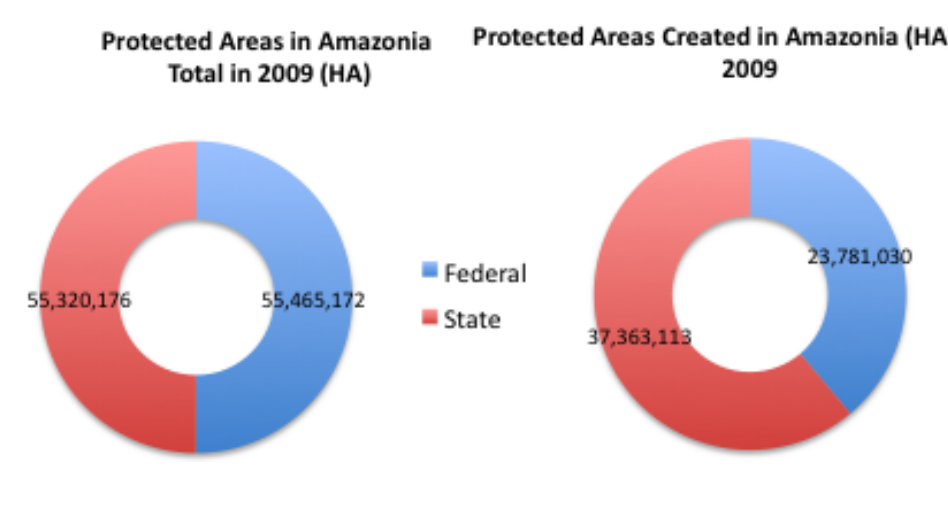
Figure 1. Protected areas in